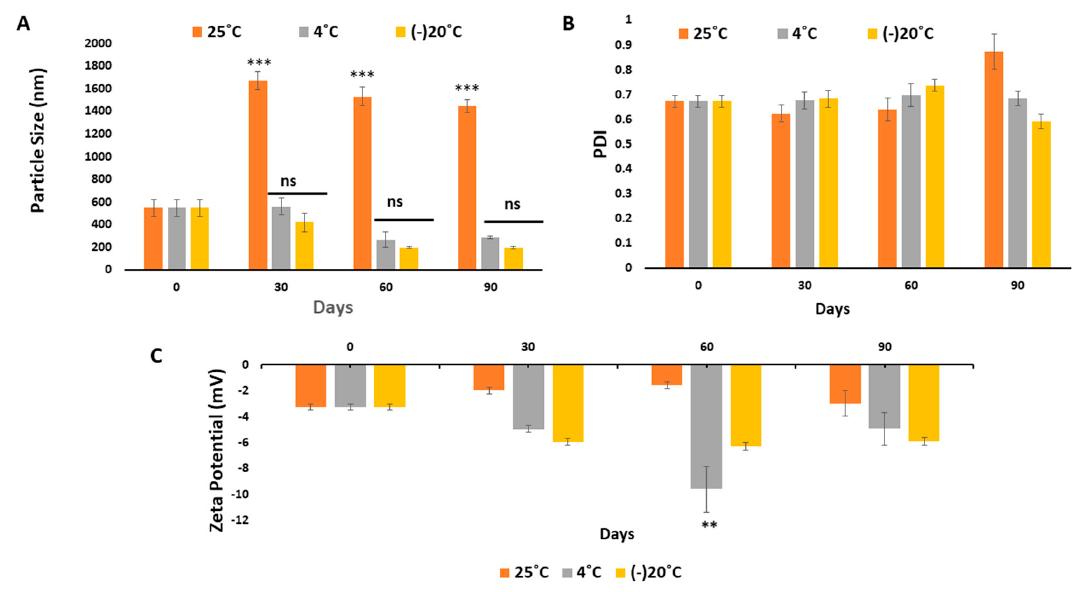
Figure 12. Physical stability analysis based on ( A ) particle Size, ( B ) PDI and ( C ) Zeta potential of Blank NaCNs for three months when placed at 25, 4 and − 20 ◦ C. The values were found to be very significant (***) ( p < 0.001) at CI of 95% vs. particle size measured at 4 and − 20 ◦ C, whereas values were significant (**) ( p < 0.01) at CI of 95% vs. zetapotential measured at 4 and − 20 ◦